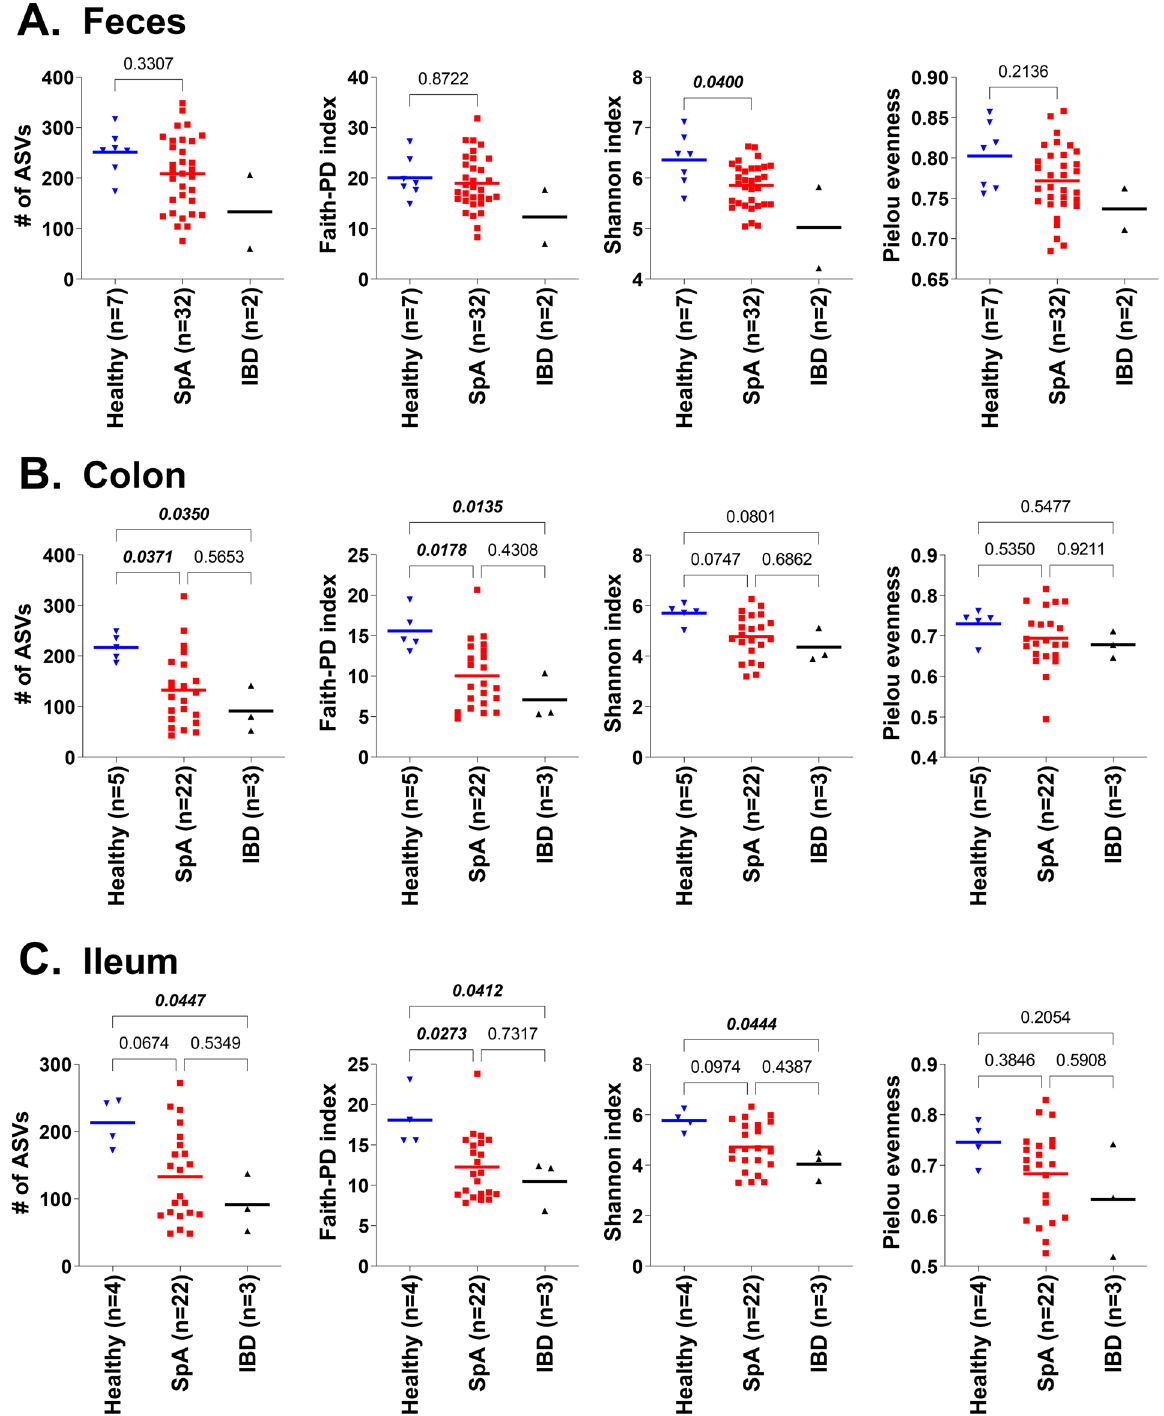
Figure 4. Healthy individuals exhibited the highest bacteria richness and diversity in different areas of the GI tract. Richness (amplicon sequence variants, ASVs), Shannon diversity, Faith phylogenetic diversity (PD) and Pielou evenness, are shown for feces ( A ), colon ( B ) and ileum ( C ) samples. Significant p-values (in bold-italics) for Tukey’s multiple comparisons test are shown. SpA spondylarthritis, IBD inflammatory bowel disease. For IBD samples, statistical analysis was only performed for ileum and colon, where we get at least three samples. This group was included to exemplify gut